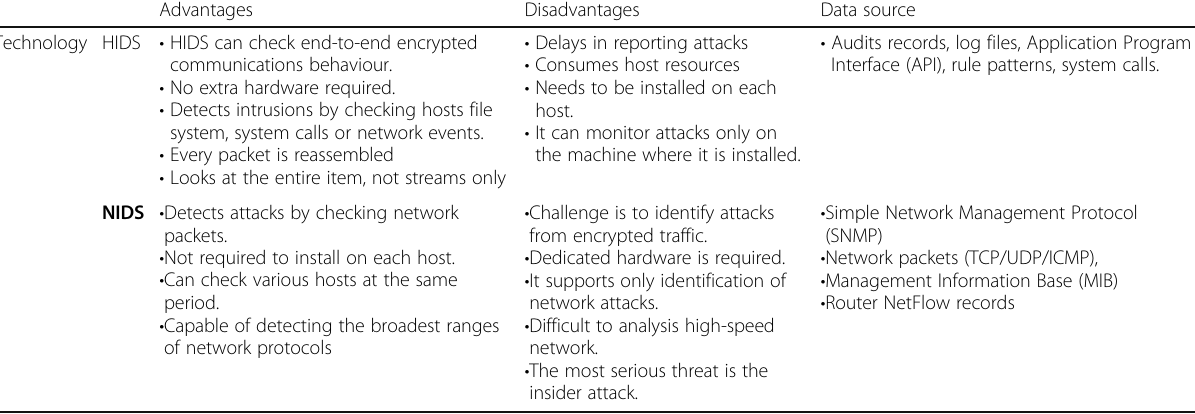
Table 4 Comparison of IDS technology types based on their positioning within the computer system